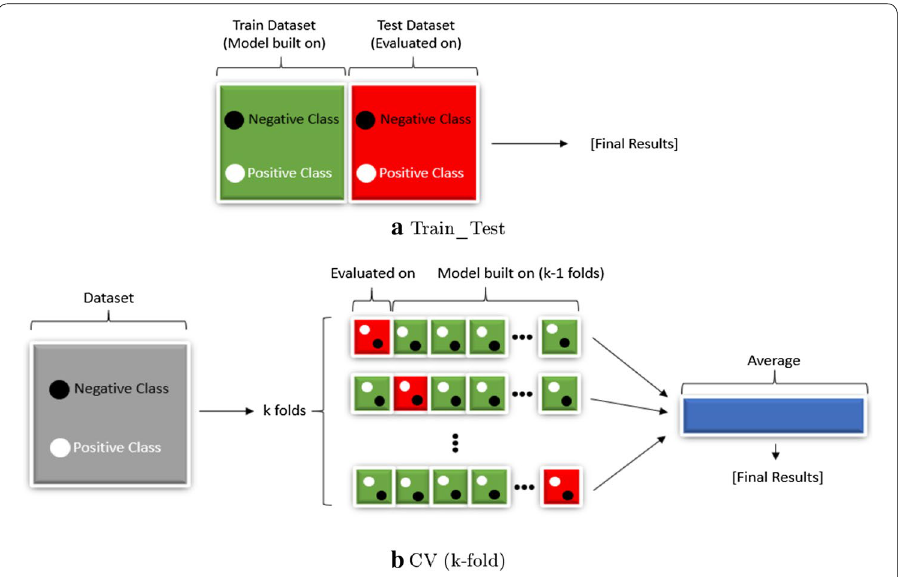
Fig. 1 Flowcharts: model evaluation